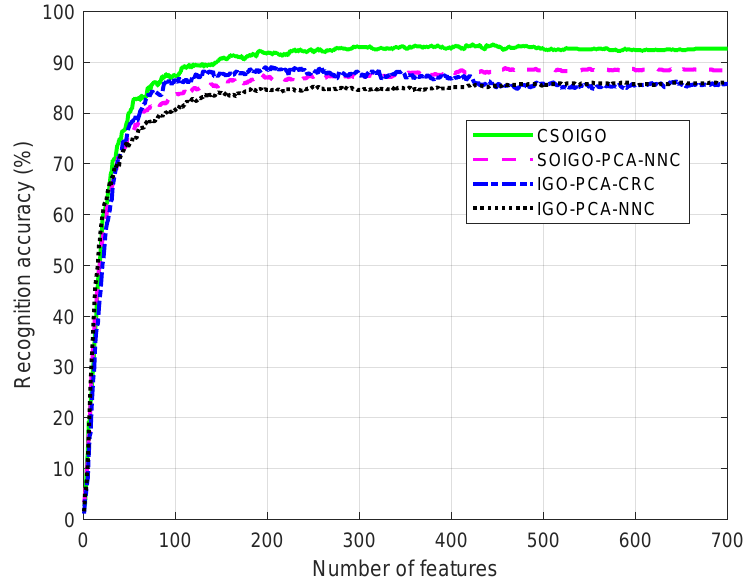
Figure 7. Recognition accuracy versus different numbers of features when the percentage of occlusion is 30%.